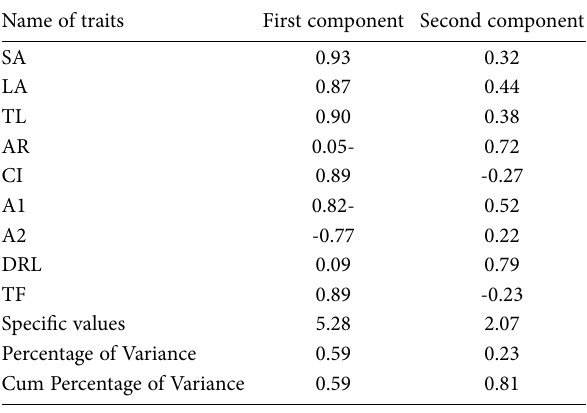
Table 5. Specific values of variance percentage and coefficients of specific vectors in analysing main components.